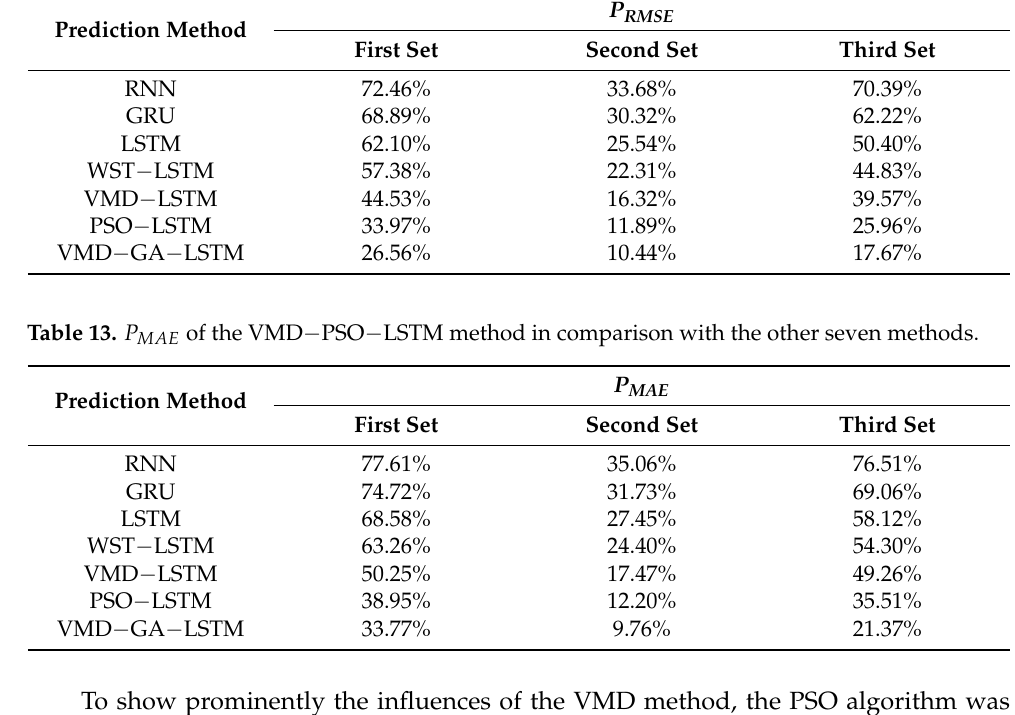
Table 12. P RMSE of the VMD − PSO − LSTM method in comparison with the other seven methods. Prediction Method